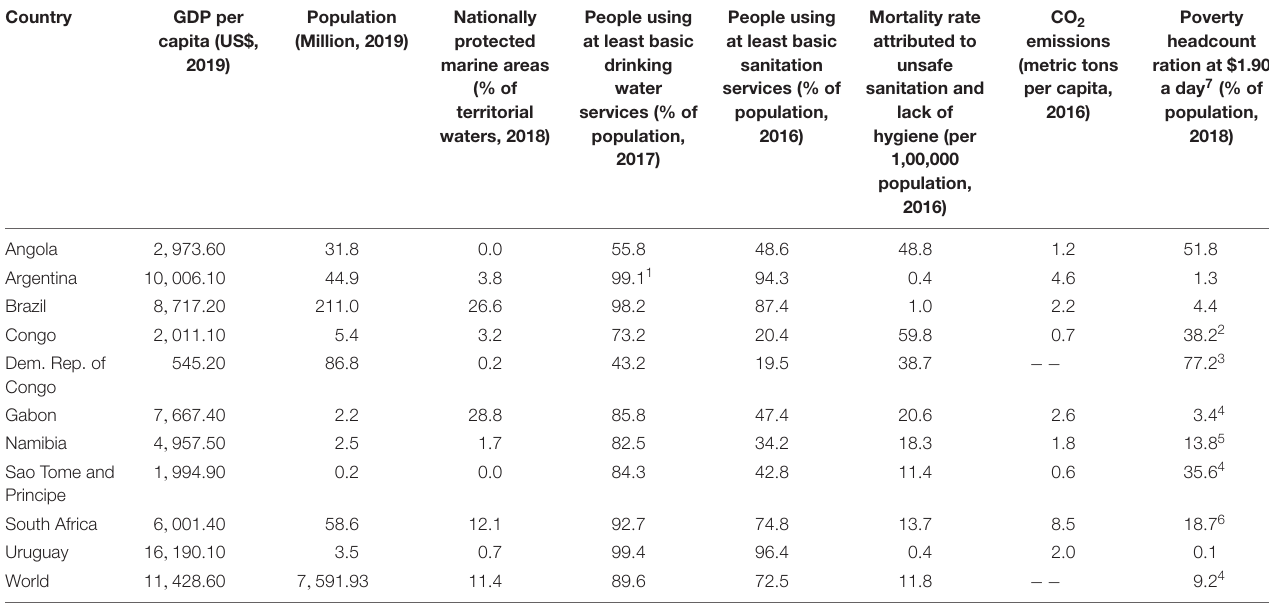
TABLE 2 | Socio-economic data for South Atlantic bordering countries (World Bank, 2020).